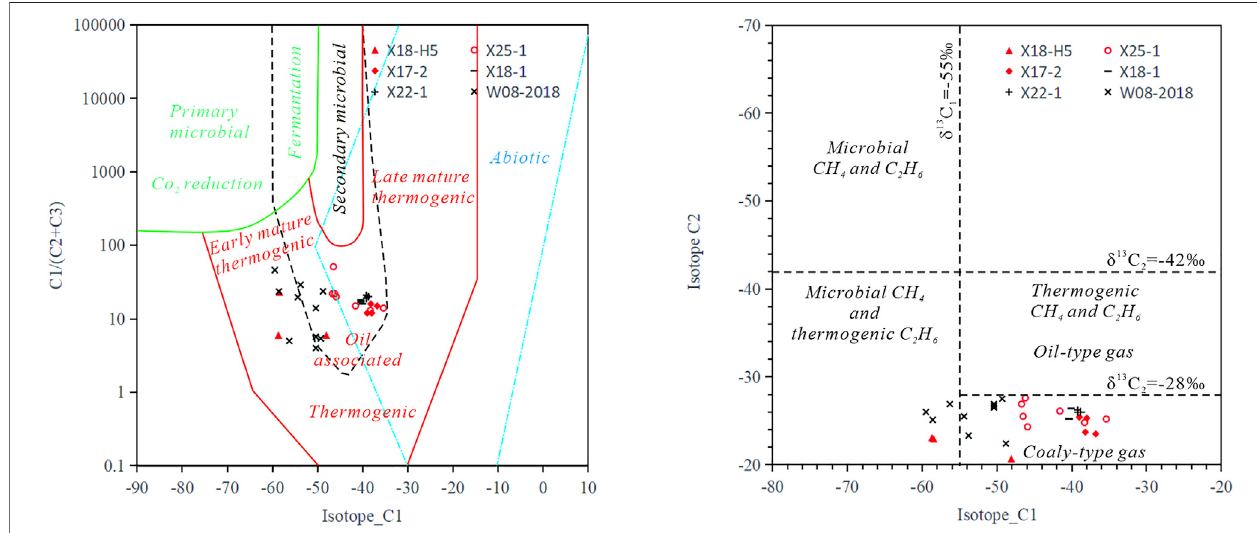
FIGURE 2 | Identi fi cation plate of gas source types of gas chimney hydrate in Qiongdongnan Basin.